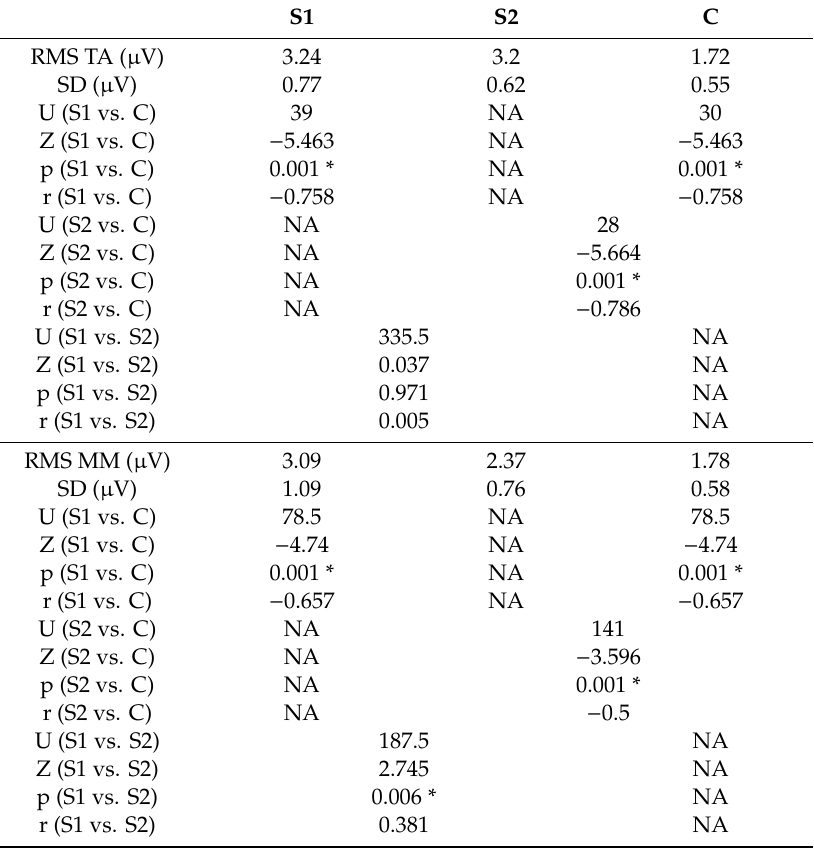
Table 2. Comparing means of bioelectric activity of temporalis anterior (root mean square (RMS) TA) and masseter muscle (RMS MM) during resting mandibular position.